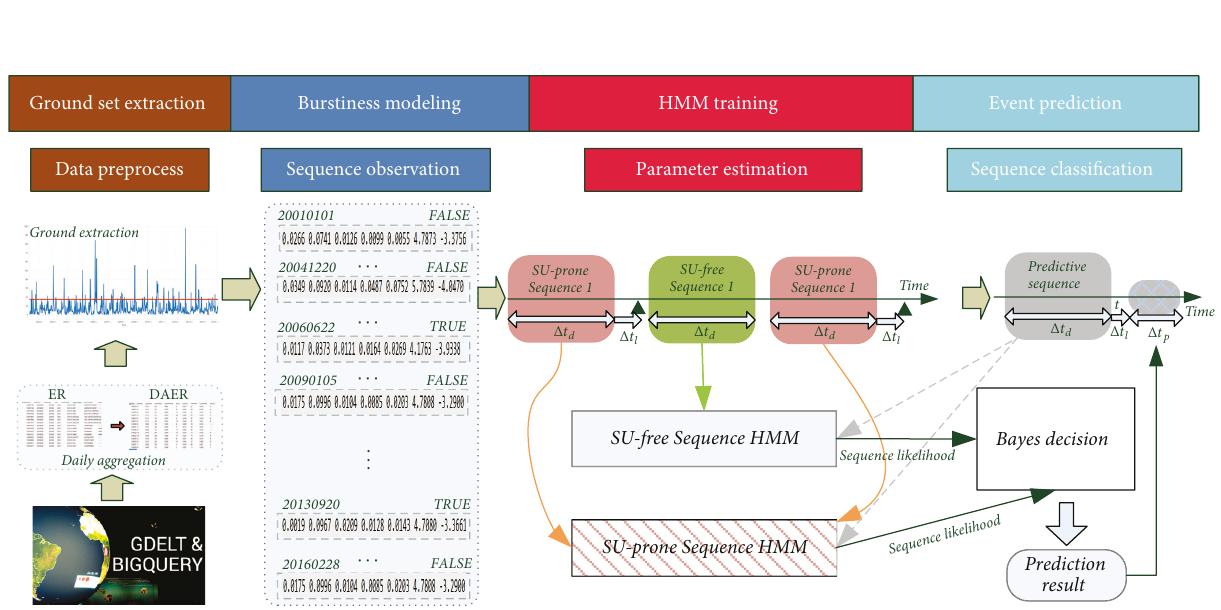
Figure 3: The proposed HMMs-based social unrest event prediction framework: two HMMs are trained, with one for SU-prone sequences and one for SU-free sequences. SU-prone sequences consist of observations within a time window of length Δ𝑡 𝑑 preceding a social unrest event ( 󳵳 ) by lead time Δ𝑡 𝑙 . SU-free sequences consist of observations at times when no social unrest event was imminent. 𝑡 is the time the prediction is performed at. Δ𝑡 𝑝 is the prediction